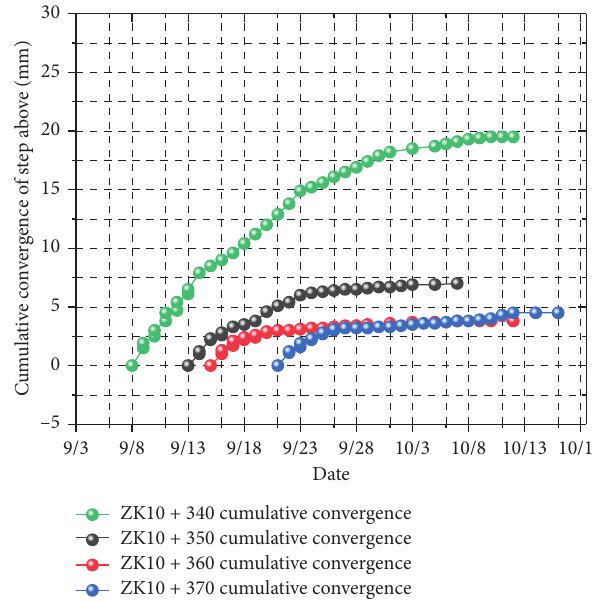
Figure 21: Cumulative convergence of the upper step in the four test sections.